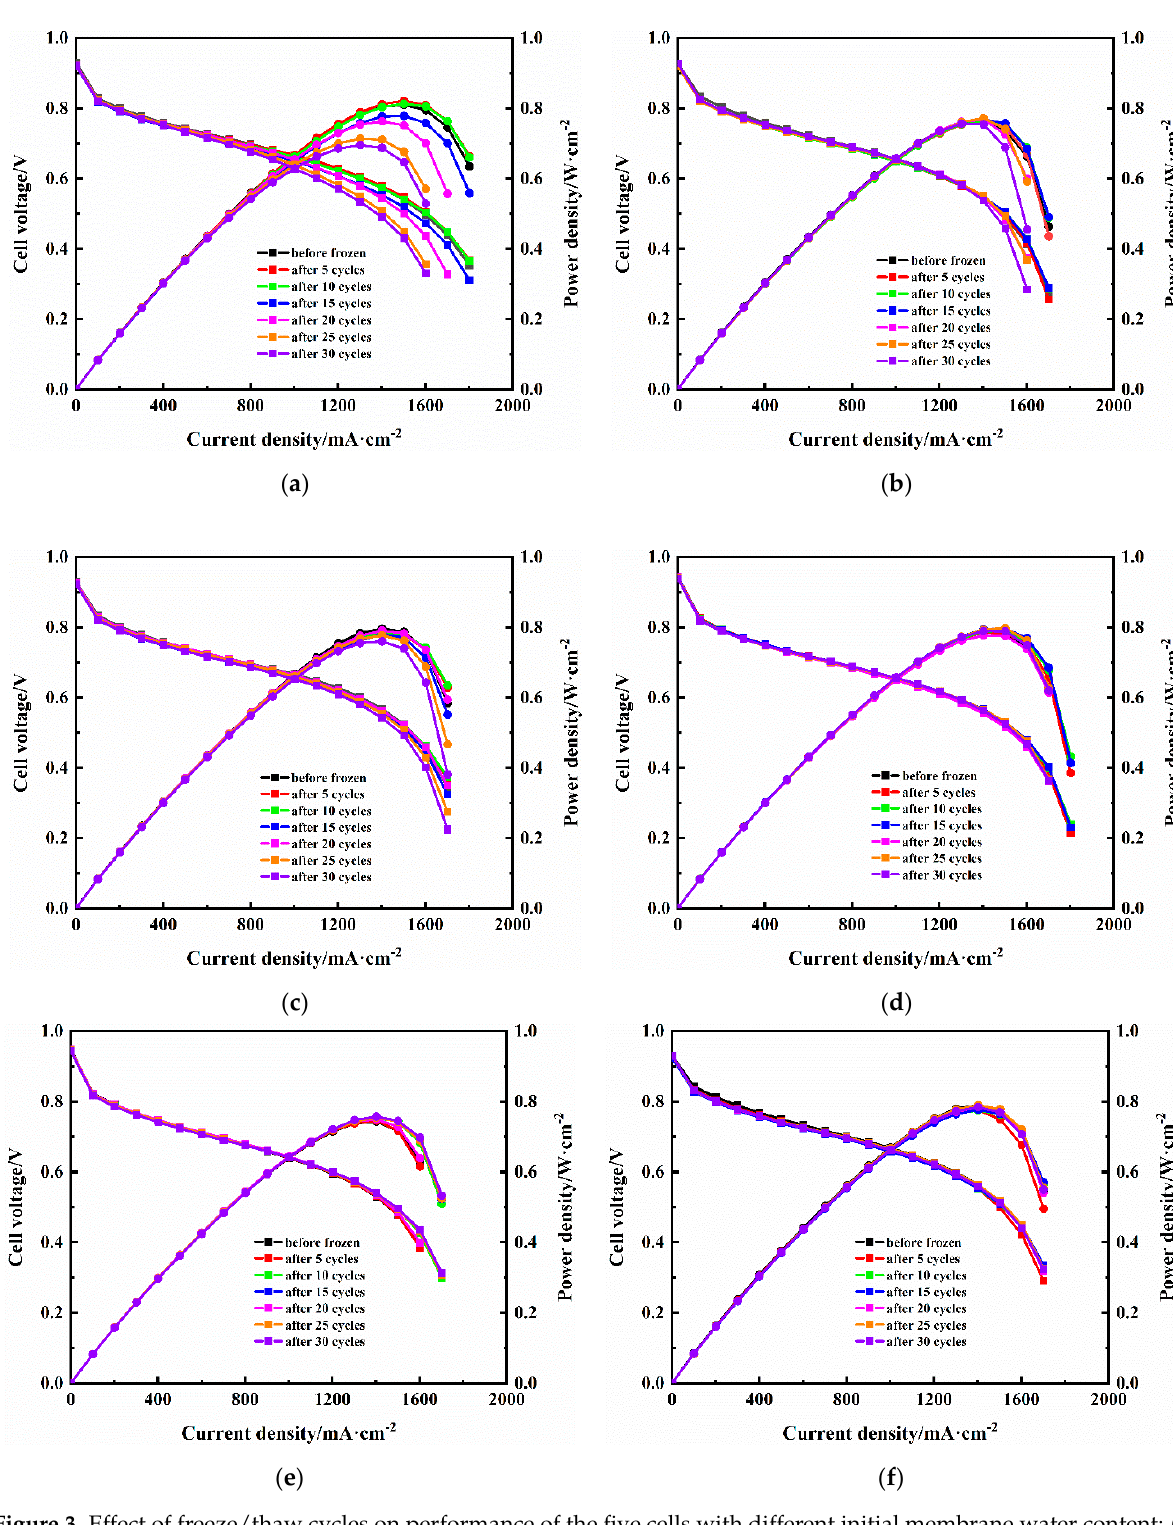
Figure 3. Effect of freeze/thaw cycles on performance of the five cells with different initial membrane water content: ( a ) λ = 14.0 (cell-1); ( b ) λ = 12.0 (cell-2); ( c ) λ = 10.7 (cell-3); ( d ) λ = 8.2 (cell-4); ( e ) λ = 7.7 (cell-5); and ( f ) cell-6 without freezing.